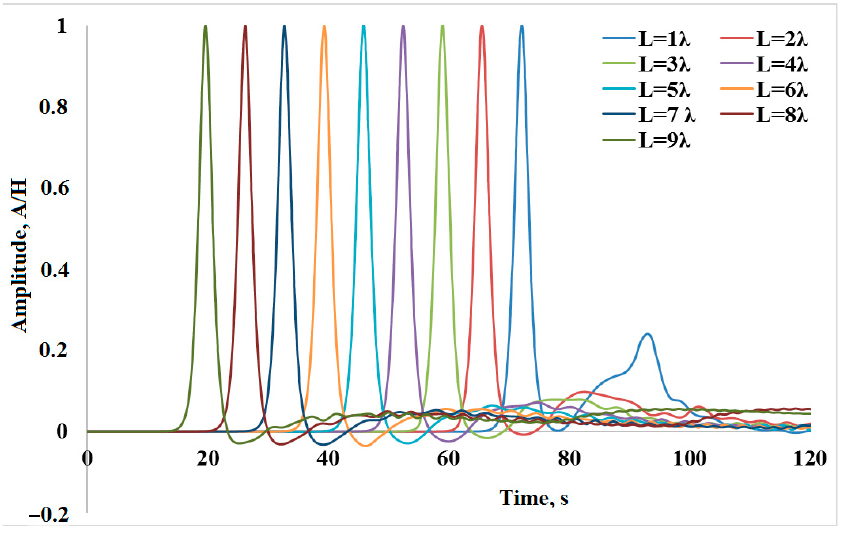
Figure 5. Tide gauge data with different types of distribution of the geometric factor ε .